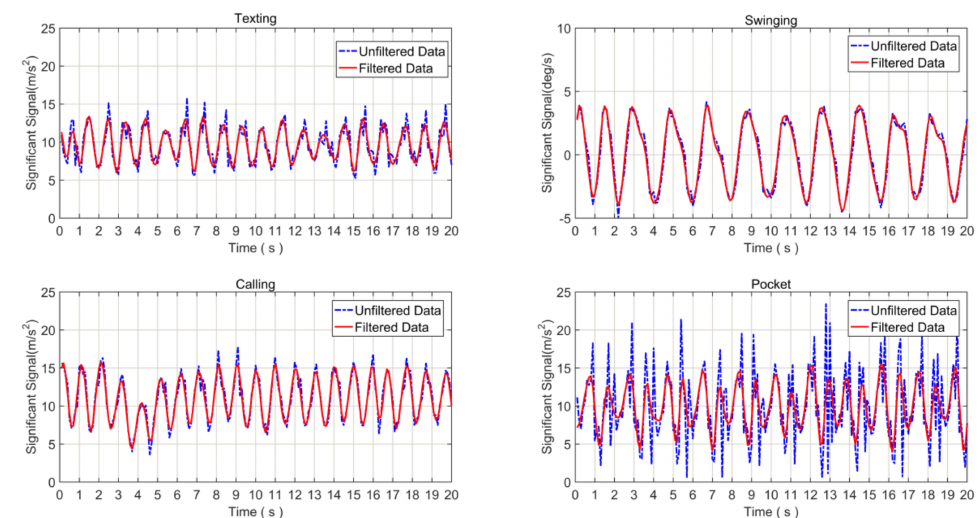
Figure 6. Comparison of the raw data and the output after